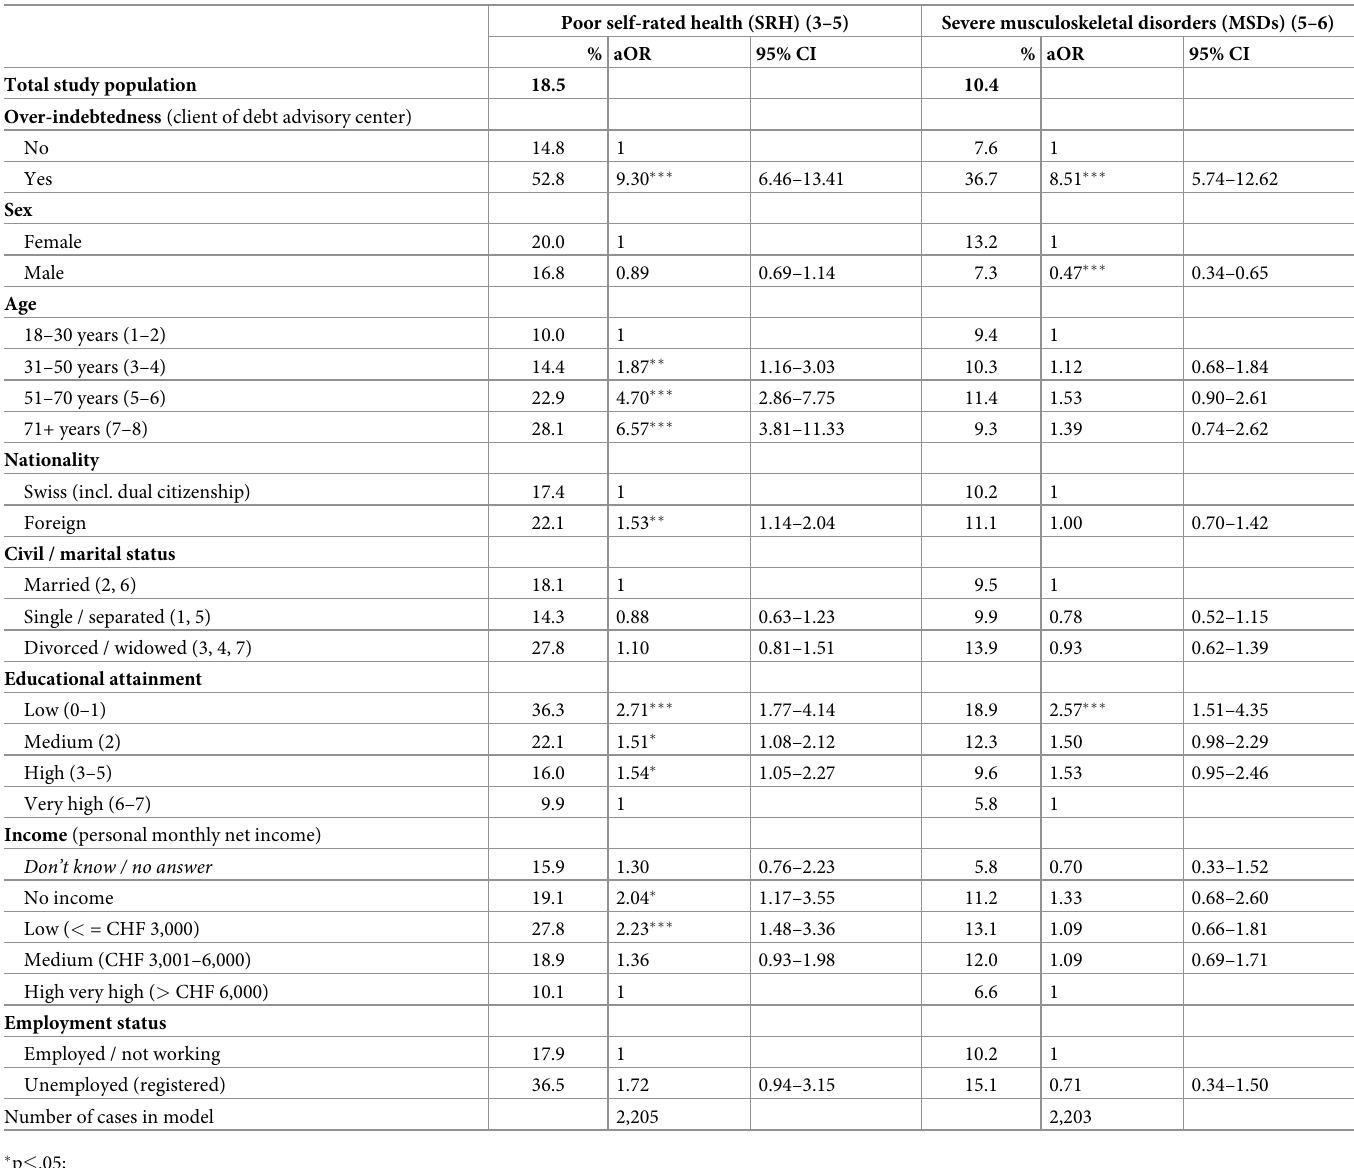
Table 3. Association of over-indebtedness and covariates with physical health problems (N =